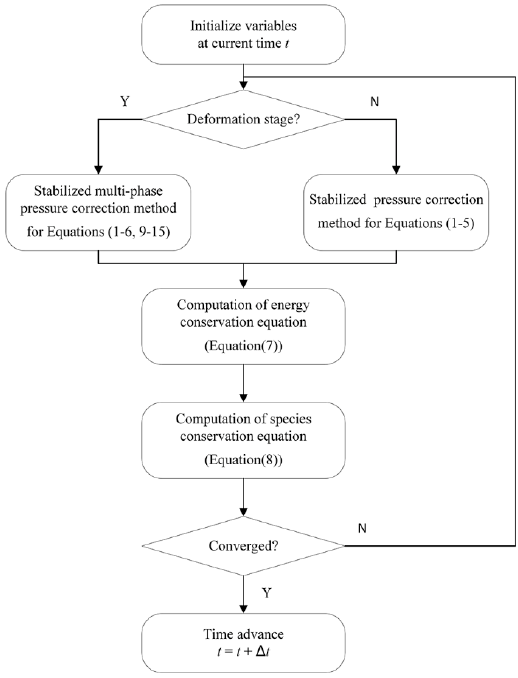
Figure 1. Schematic of the solution algorithm for the single-phase/two-phase integrated model.